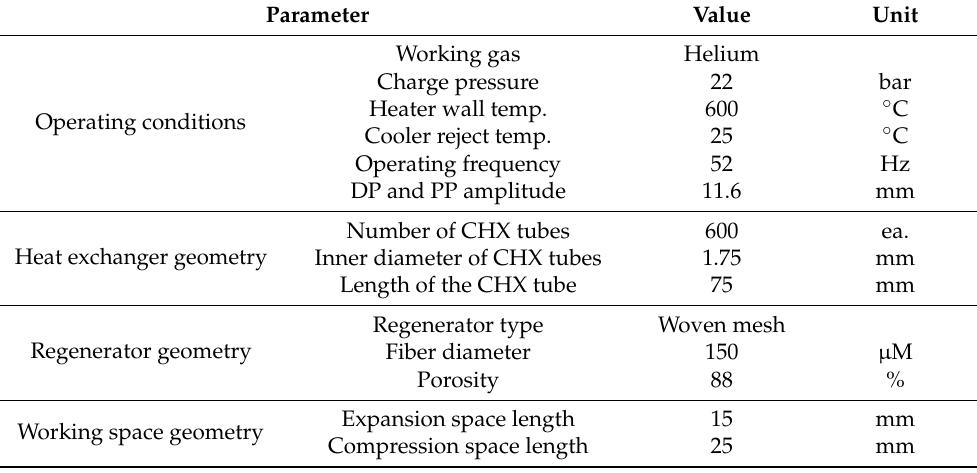
Figure 1. Cross-sectional view of a 3 kW FPSE design developed by Nexergy lab at Seoultech. Table 1. Design parameters of the